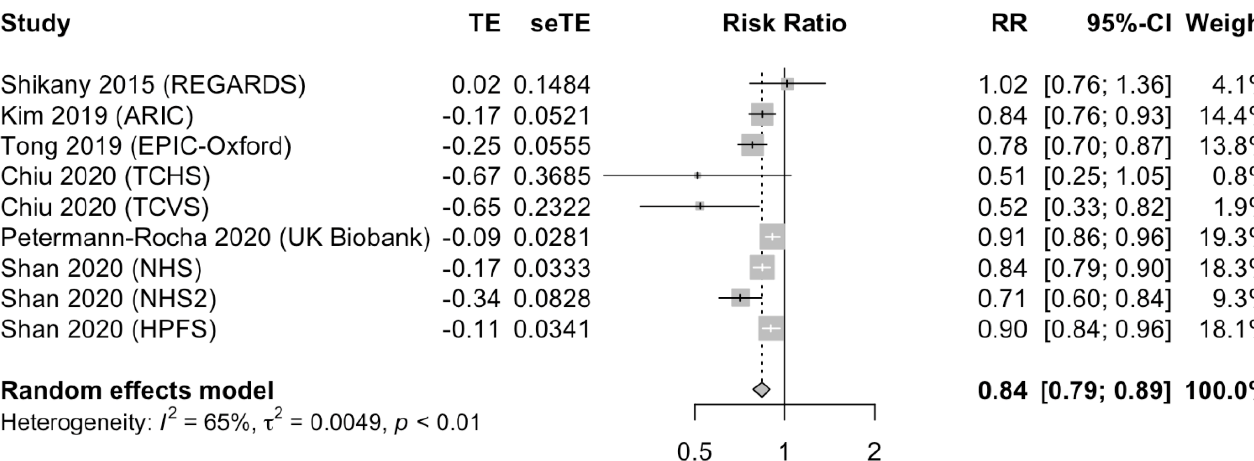
Figure 2. Forest plot of the adjusted relative risk (RR) of cardiovascular disease for the highest versus the lowest adherence to plant-based dietary patterns. Pooled risk estimates and 95% confidence intervals (CI) using a random effects model for meta-analysis are in bold. Abbreviations: ARIC, Atherosclerosis Risk in Communities Study; CI, confidence interval; EPIC, European Prospective Investigation into Cancer and Nutrition; NHS, Nurses’ Health Study, NHS2, Nurses’ Health Study II; REGARDS, Reasons for Geographic and Racial Differences in Stroke; RR, relative risk; seTE, standard error of treatment effect; TCHS, Tzuchi Health Study; TCVS, Tzuchi Vegetarian Study; TE, treatment effect; UK, United Kingdom.